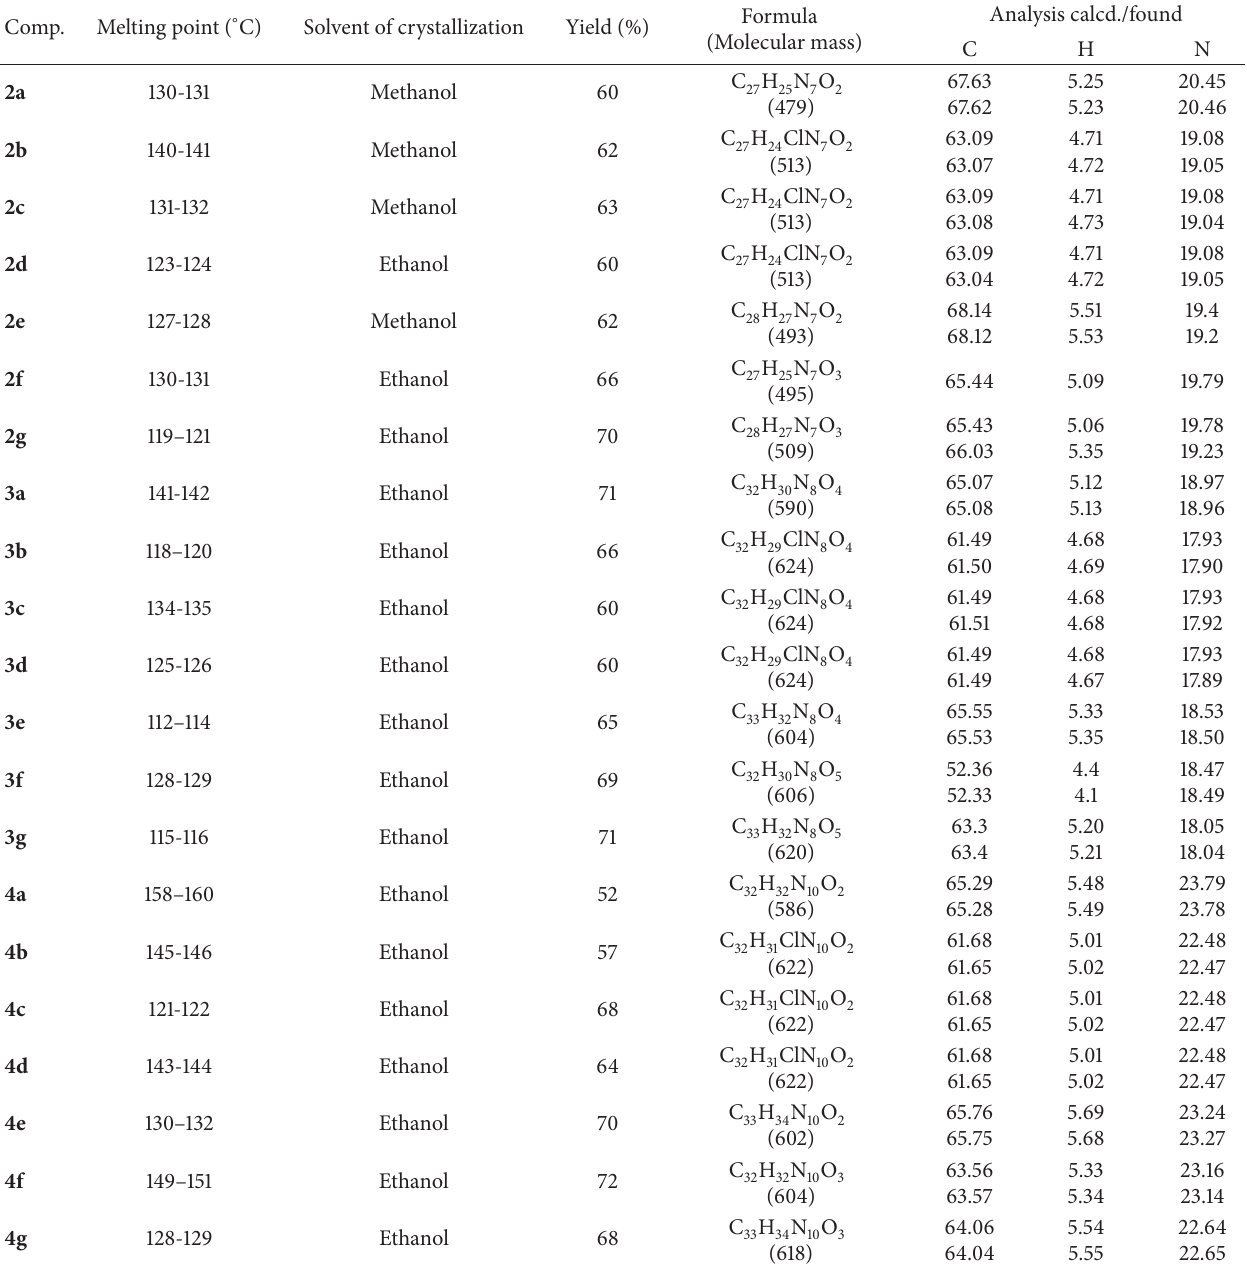
Table 1: Characterization data of synthesized